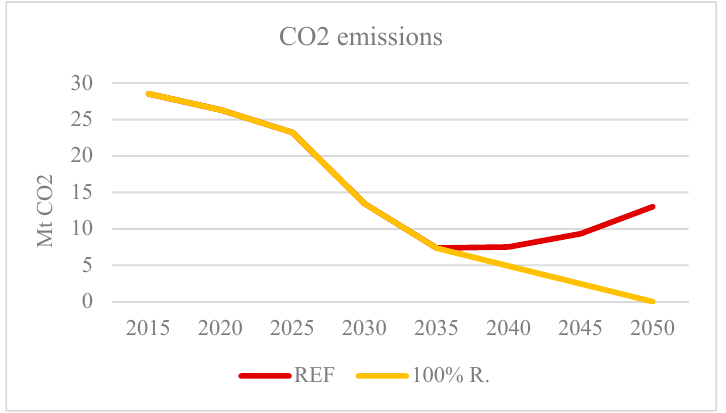
Figure 4. Emissions trend for the reference (REF) and the 100% renewable (100% R.) scenarios.